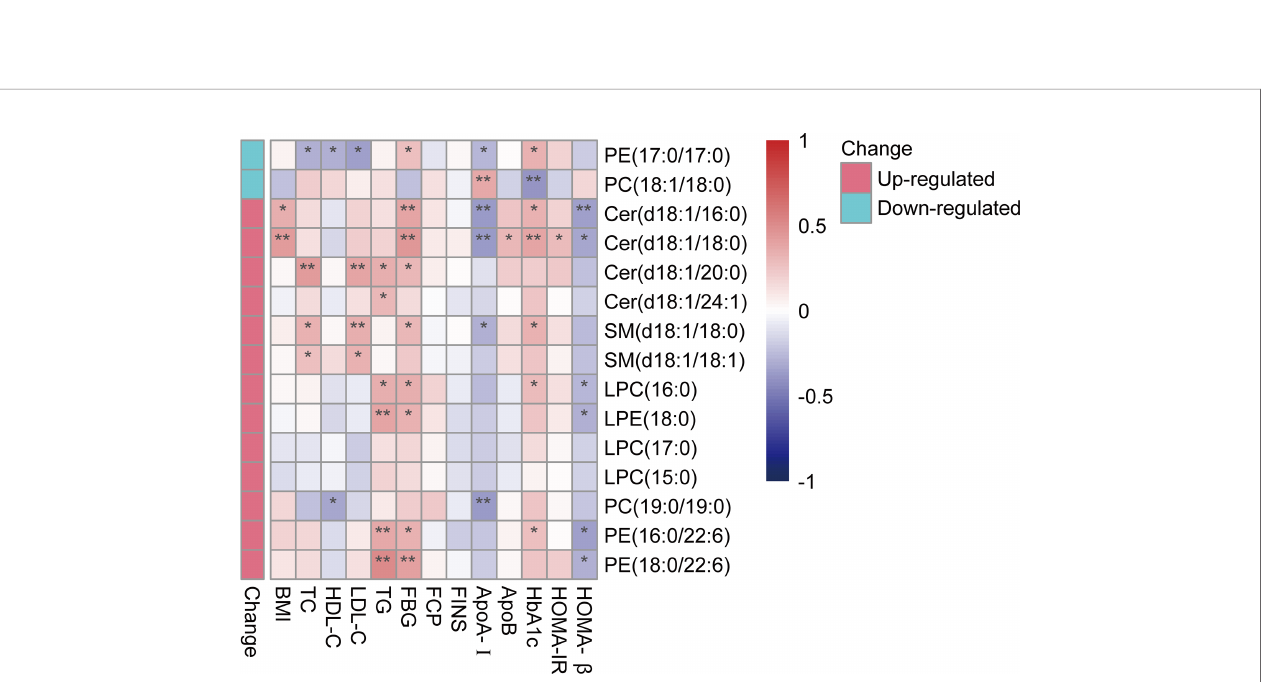
FIGURE 2 | Correlation heatmap between differentially abundant lipids and key clinical characteristics. A bipolar color progression with scales on the right of the fi gure represented positive correlation (red) and negative correlation (blue), respectively. Statistical signi fi cances are indicated by asterisks. * P < 0.05; ** P < 0.01. LPC, lysophosphatidylcholine; PE, phosphatidylethanolamine; LPE, lysophosphatidylethanolamine; PC, phosphatidylcholine; SM, sphingomyelin; Cer, ceramide.